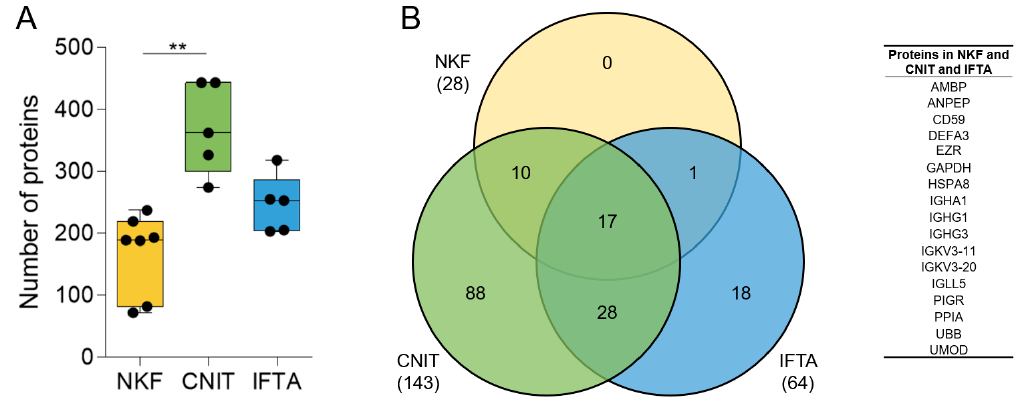
Figure 1. ( A ) Number of proteins found by mass-spectrometry in uEV samples in each group. Whiskers represent minimum to maximum; horizontal line represents the mean (** p < 0.01). ( B ) Venn diagram showing the number of coinciding proteins between the samples of each group (in brackets) and between the all the samples in the study (number in the corresponding circles). On the right, list of the 17 proteins found in all samples.